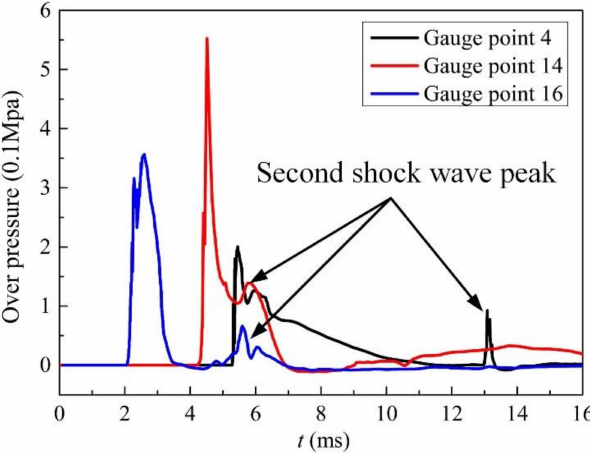
Figure 12. Pressure vs. time curves of some gauge points in air. A comparison of the peak pressures of gauge points in the same row is shown in Figure 13. The trend of peak pressure values at gauge points (1–8) in the same row of explosives reflects the peak pressure within 1.0 m from the explosion center decreases rapidly with the increase in the distance that between the gauge point and the explosion center. In the range of 1.0 m–2.0 m from the explosion center, the peak pressure decreases slowly, and the damage capability is significantly reduced. The change trend of the peak pressure at the other row of gauge points (10–18) shows that the pressure peaks of the gauge points 15 and 16 are relatively high due to the superposition of the detonation wave reflected on the steel plate.